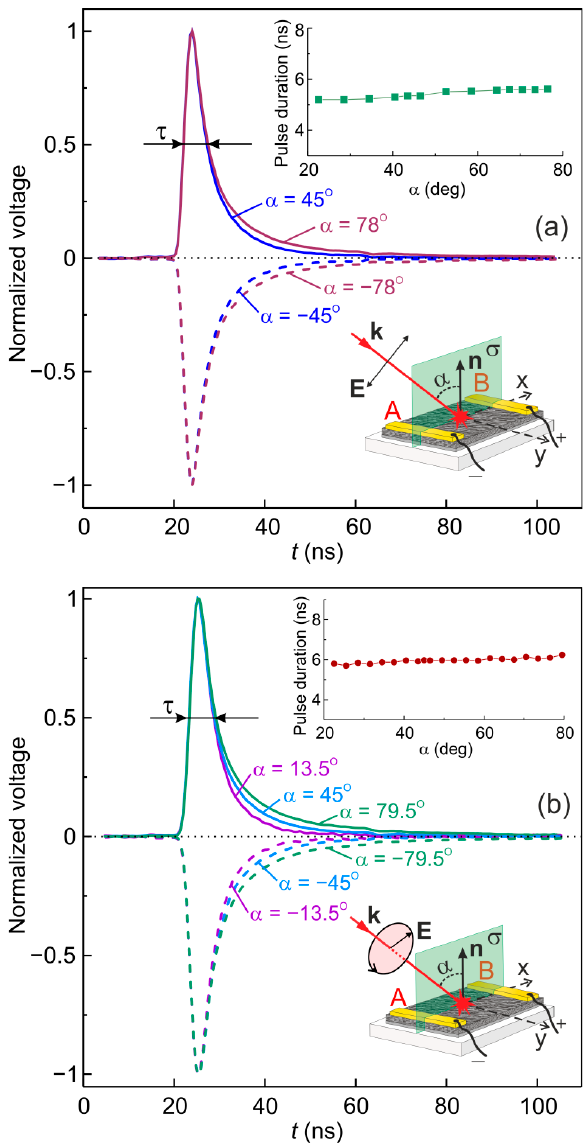
Figure 3. The waveforms of the longitudinal photovoltage pulses normalized to their extreme values at ( a ) linear polarization ( Φ = 0, p -polarization) and ( b ) circular polarization recorded at positive (solid lines) and negative (dashed lines) incidence angles α . The upper insets show the corresponding dependences of the recorded pulse durations τ on the angle of incidence. The bottom insets show the sketches of the experimental setups.